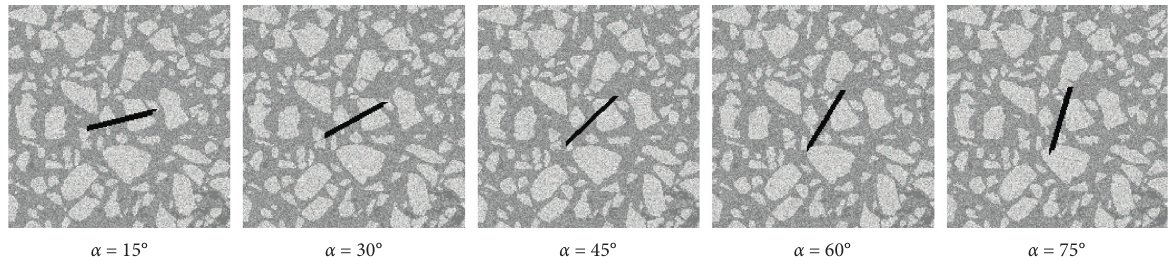
Figure 4: Digital images of concrete materials with different inclination angles flaw.